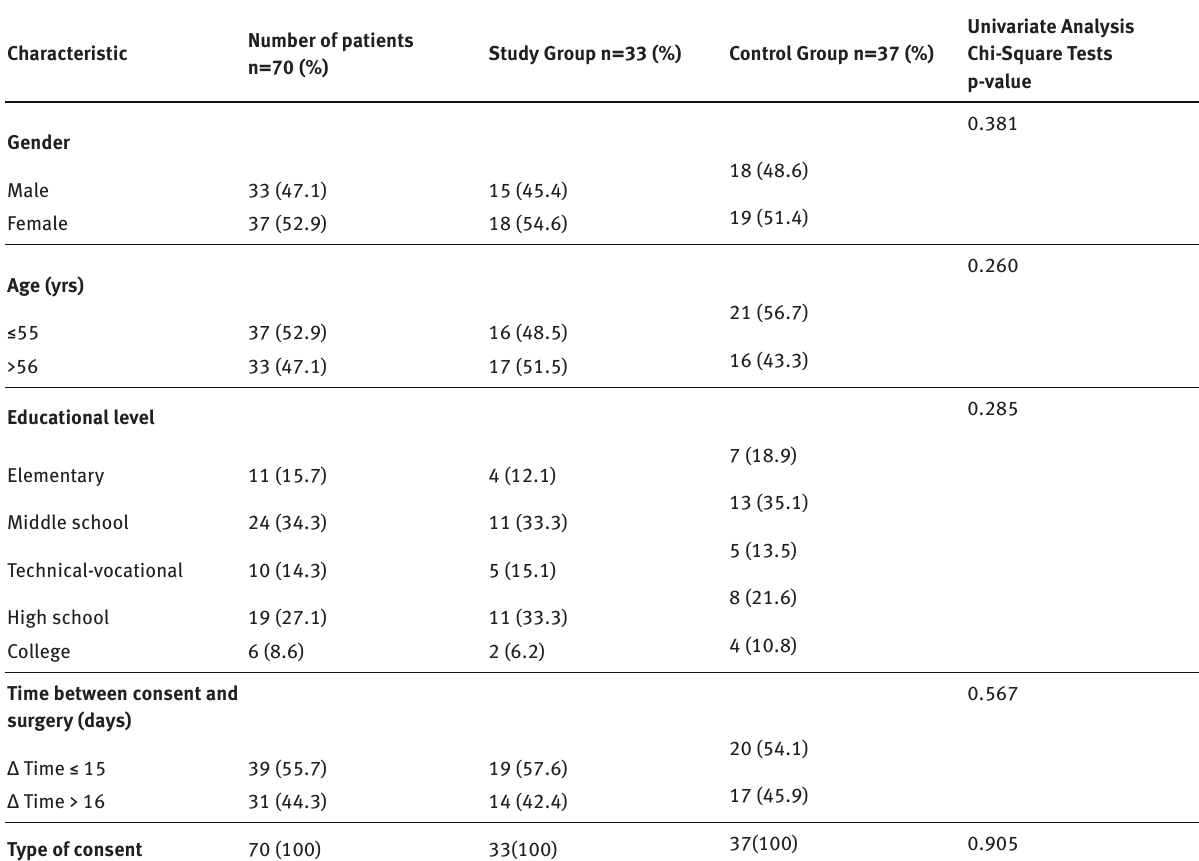
Table 3: Results of interferential analysis of the categorical variables (two-sided Monte Carlo and Fisher’s exact test).